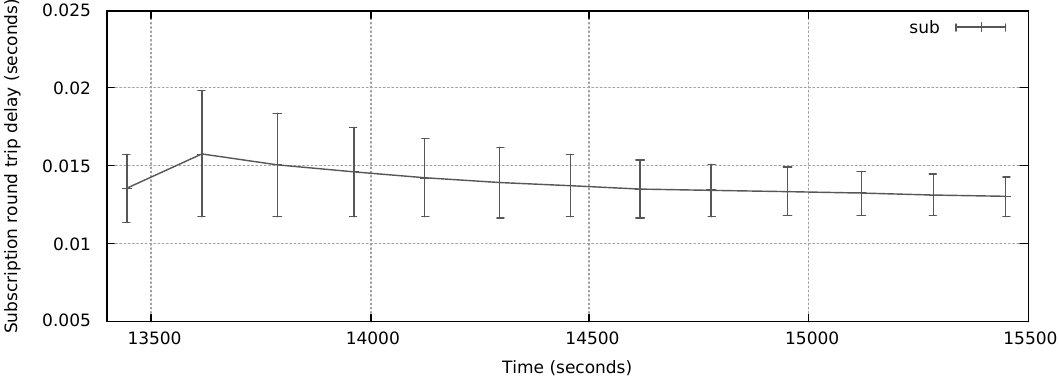
Figure 19. Mean round trip time of PGCS subscriptions for IEEE 802.15.4 channel changing command from PSS. Wi-Fi network delay between Host 1 and Host 2 is included